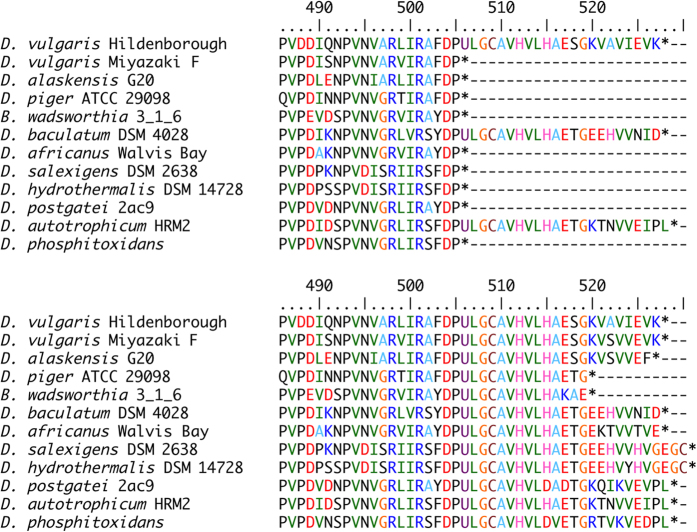
The C-terminal sequences of extant [NiFeSe] Hases, in which the in-frame opal codon was read through as Sec (U).Upper: Amino acid sequence annotated in GenBank/NCBI. Lower: Alternative translation of the in-frame opal codon as Sec (U).